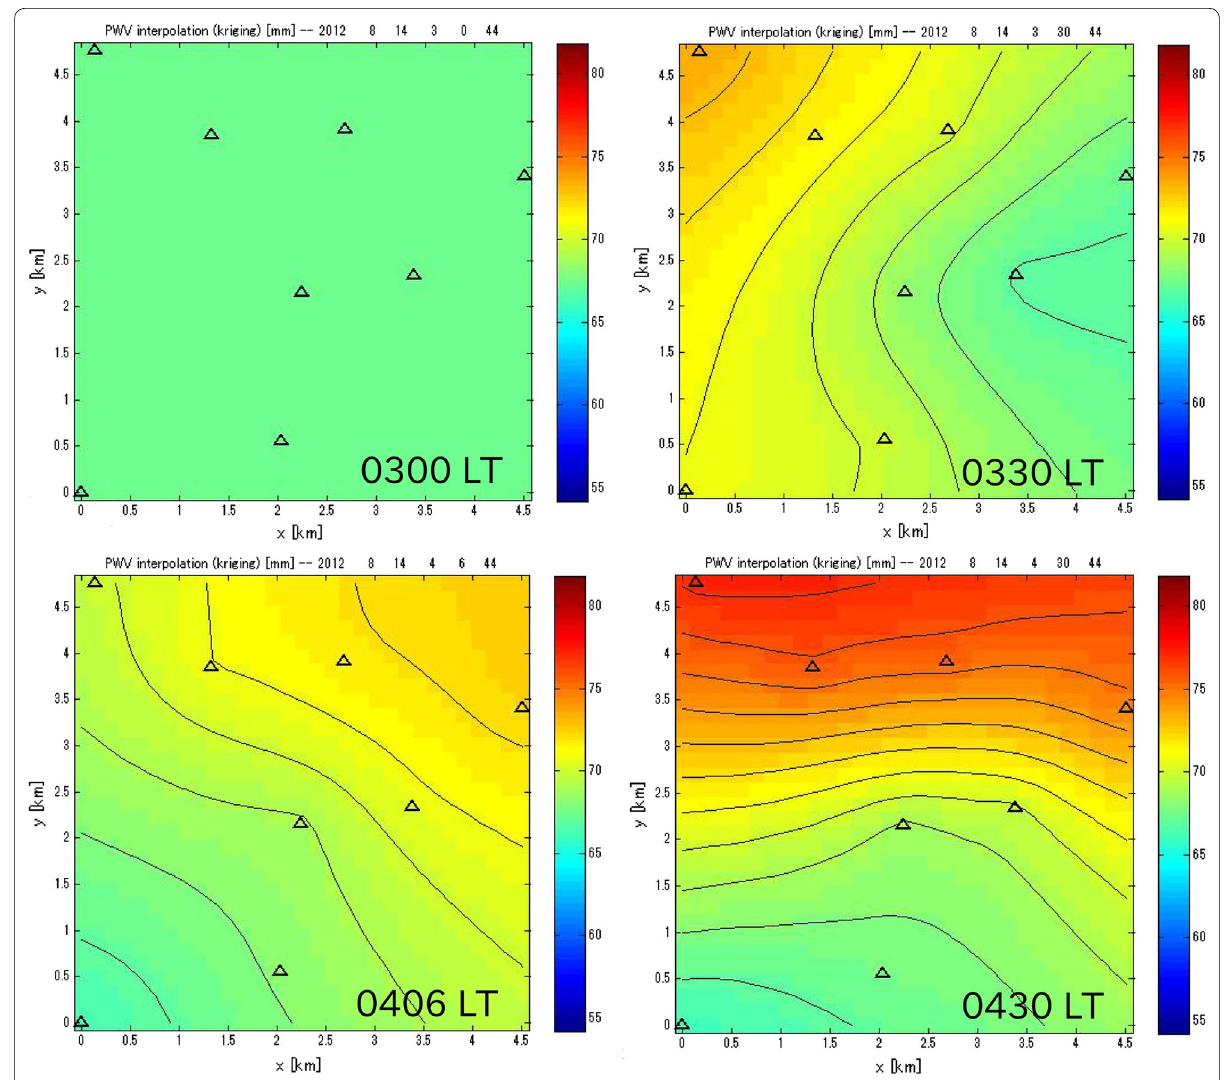
Fig. 4 PWV SPD-H distributions observed by the Uji network about every 30 min from 0300 LT to 0430 LT on August 14,